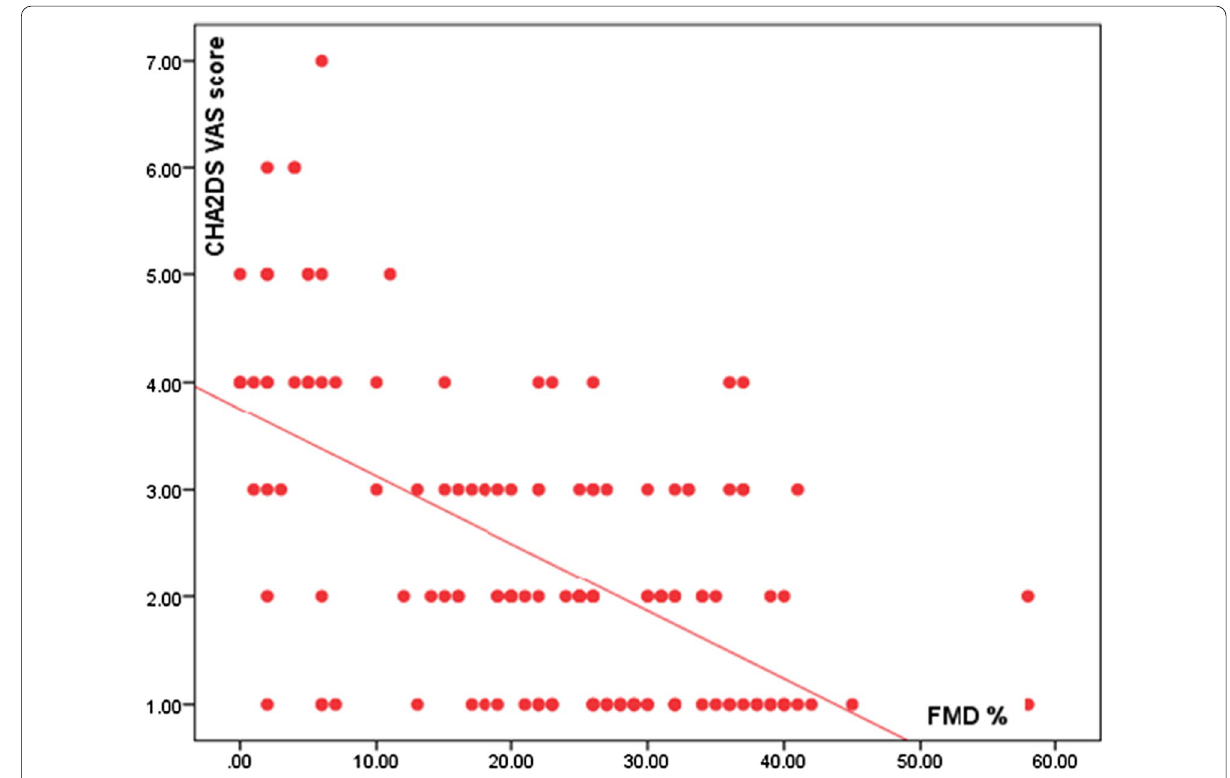
Fig. 2 Correlation between the FMD percentage and the CHA2DS VAS